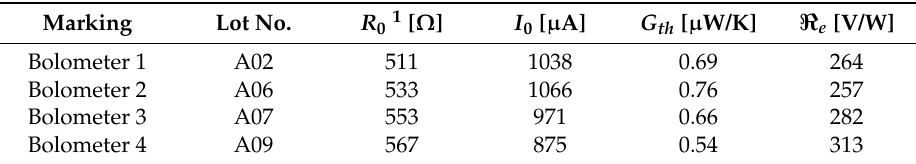
Table 1. Micro-bolometer parameters.